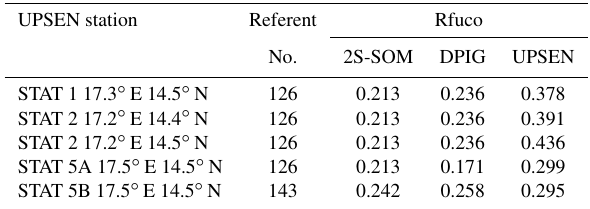
Table 3. For ship stations 1, 2, 3, 5a and 5b of the UPSEN campaign, we show the referent captured by the VIIRS observations, the fu- coxanthin ratio associated with this referent (Rfuco-2S-SOM), the fucoxanthin ratio of the closest DPIG fucoxanthin ratio captured by the neuron of the referent and the fucoxanthin ratio measured in situ during the UPSEN